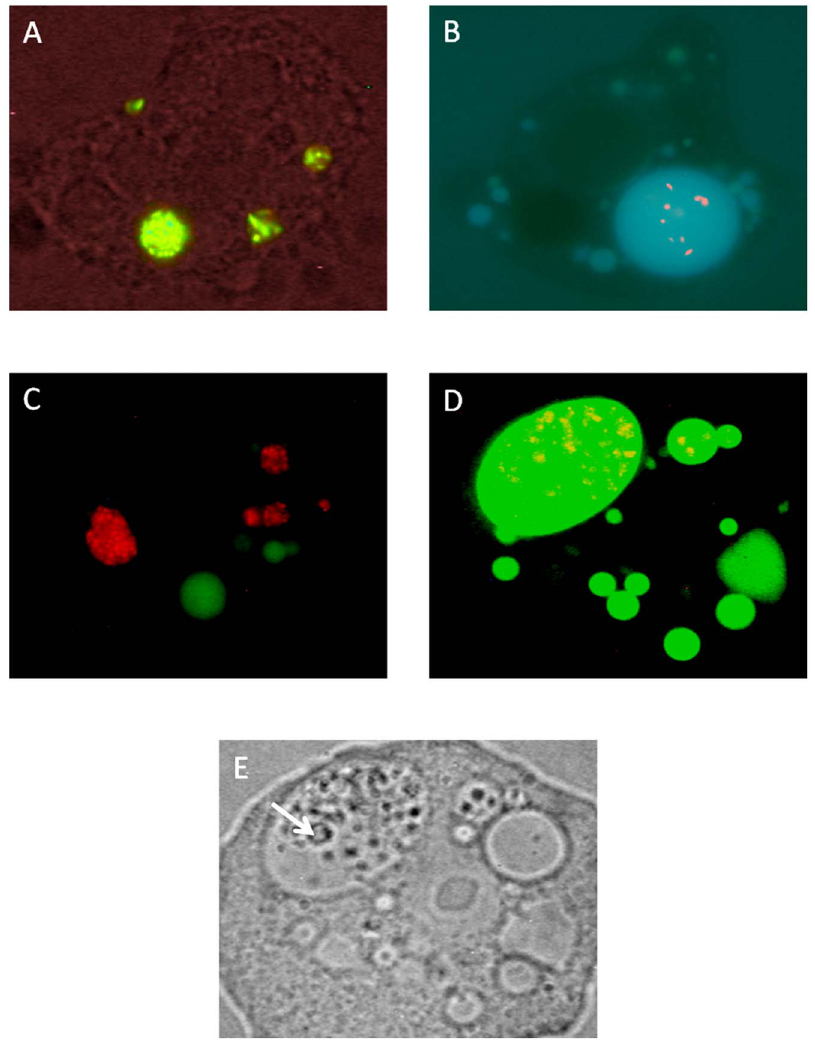
Figure 4. Viable and heat killed C.jejuni are taken up into different types of A.polyphaga vacuoles. (A) Live/Dead stained viable (green) C. jejuni , confined to tight vacuoles. (B) Live/Dead stained heat killed (red) C. jejuni residing in giant spacious vacuoles. (C) Vaculoes with CTC stained viable (red) C. jejuni do not co-localize with Alexa fluor-488 labeled dextran filled vacuoles (green). (D) Vaculoes with CTC stained heat killed (red) C. jejuni have taken up Alexa fluor-488 labeled dextran (green). (E) In contrast to non digestive vacuoles, giant digestive vacuoles contained smaller vesicles (arrow). Picture D and E are from the same amoeba. ZEISS Axioskop (Germany) 6 63, FI 450–490 (FT 510, LP 520) and a Nikon camera COOLPIX 995 was used for fluorescence images A, C, D and bright field image E. OLYMPUS BX 50 (Japan) 6 100 and an OLYMPUS camera DP 50 was used for fluorescence image B.